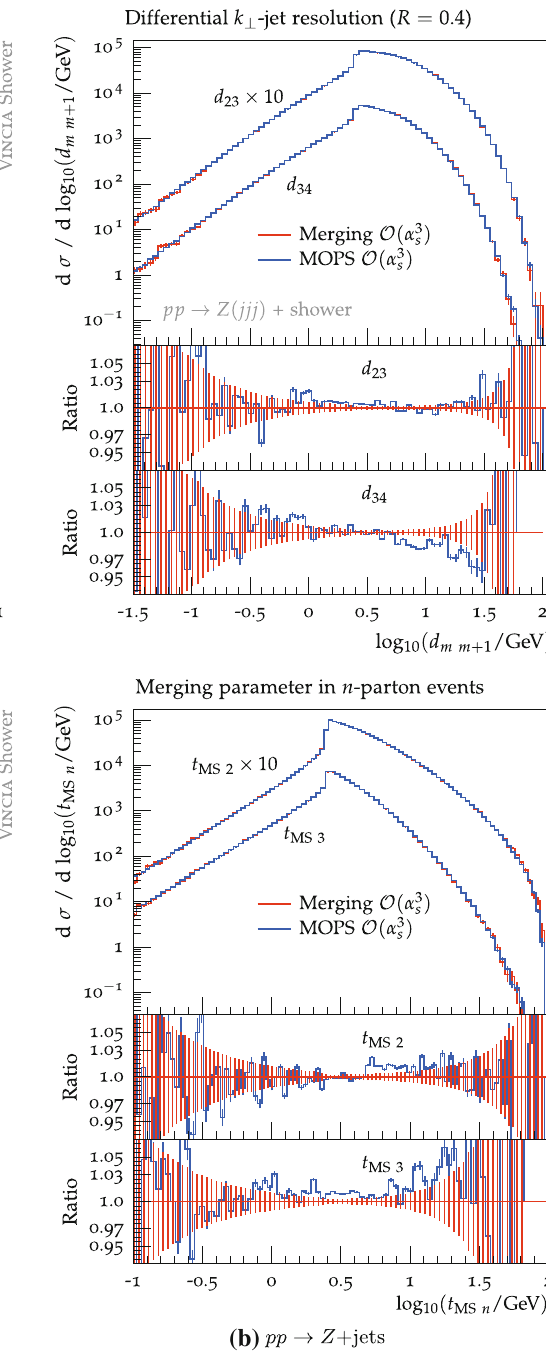
Fig. 9 Parton-level results: the distribution of the merging scale in exclusive 4- and 5-parton events ( bottom ) and the logarithmic distributions of differential jet resolutions ( top ). Merged predictions with a merging-scale value of 5 GeV are compared to predictions with the MOPS